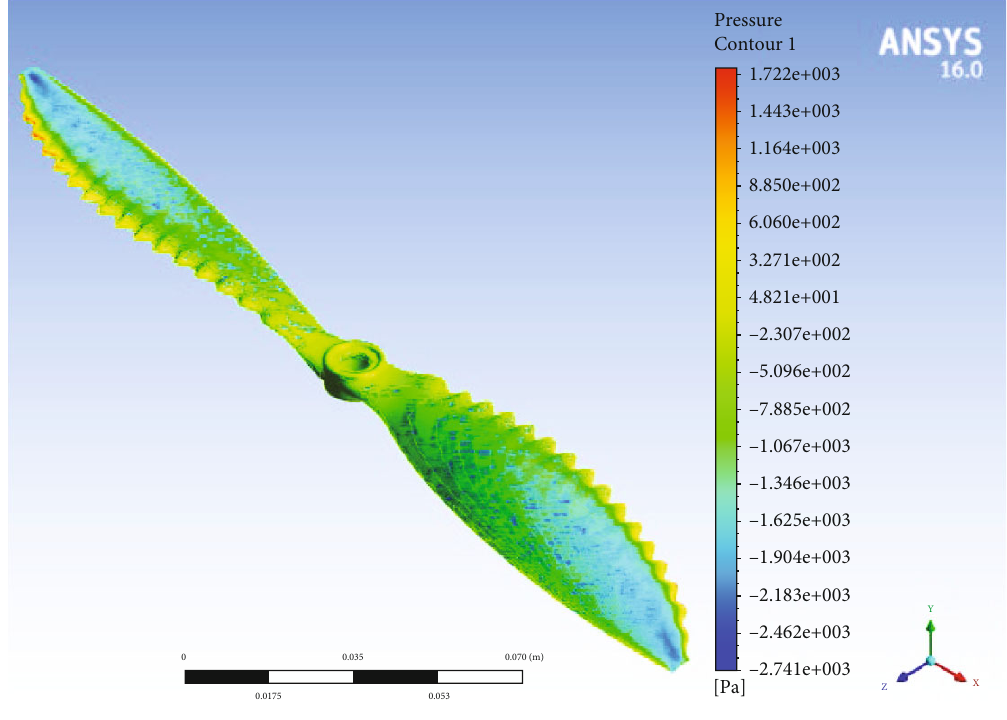
Figure 25: Pressure contour at -25 ° C temperature.